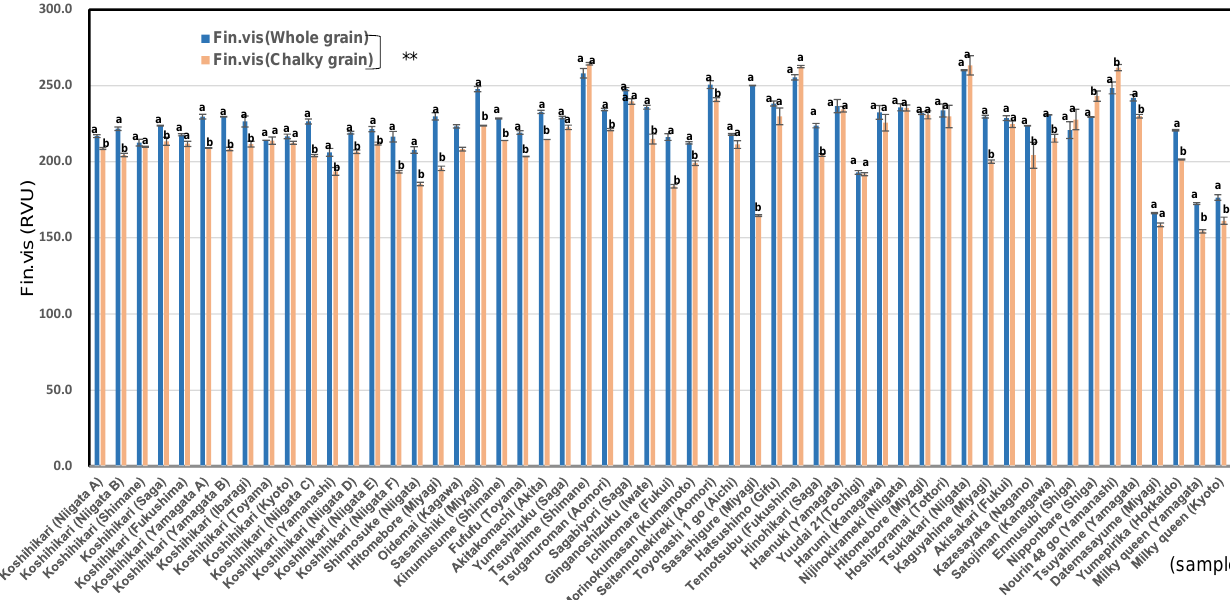
Figure 1. Final.viscosity of whole and chalky rice grains in 54 Japonica unpolished rice samples in 2020. Different letters (a, b) mean that whole and chalky grains in each same rice samples are significantly different. ** Correlation is significant at 1% by the method of Tukey’s multiple comparison.